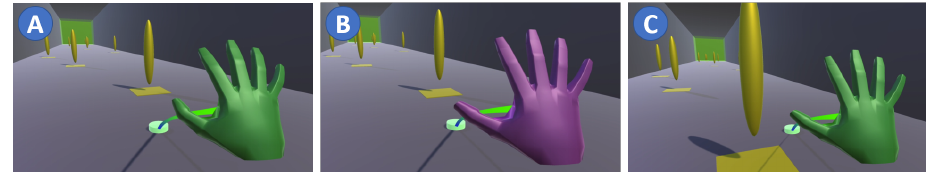
Figure 6. ( A ) Palm normal of right hand points to desired position ( B ) Hand is kept still for n = 1.5 s ( C ) User moved to